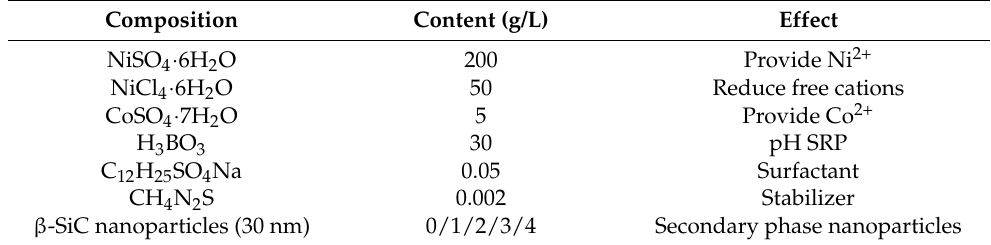
Table 2. Composition of plating solution.